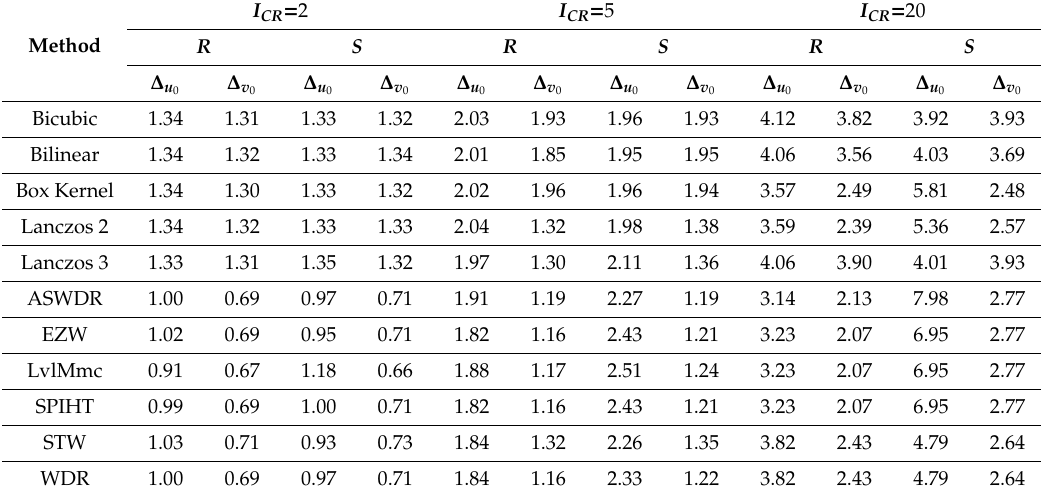
Table 3. Principal point translation ratios (calculated as shown in Figure 10) in horizontal ∆ u vertical ∆ v directions for di ff erent image compression methods and compression 0